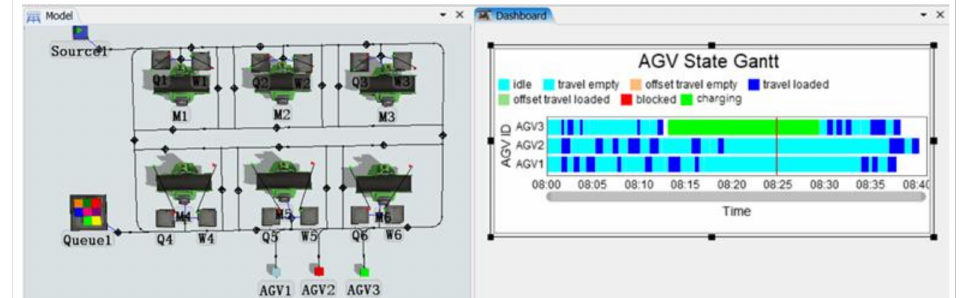
Figure 14. Evaluation results of the initial scheduling plan in Flexsim.